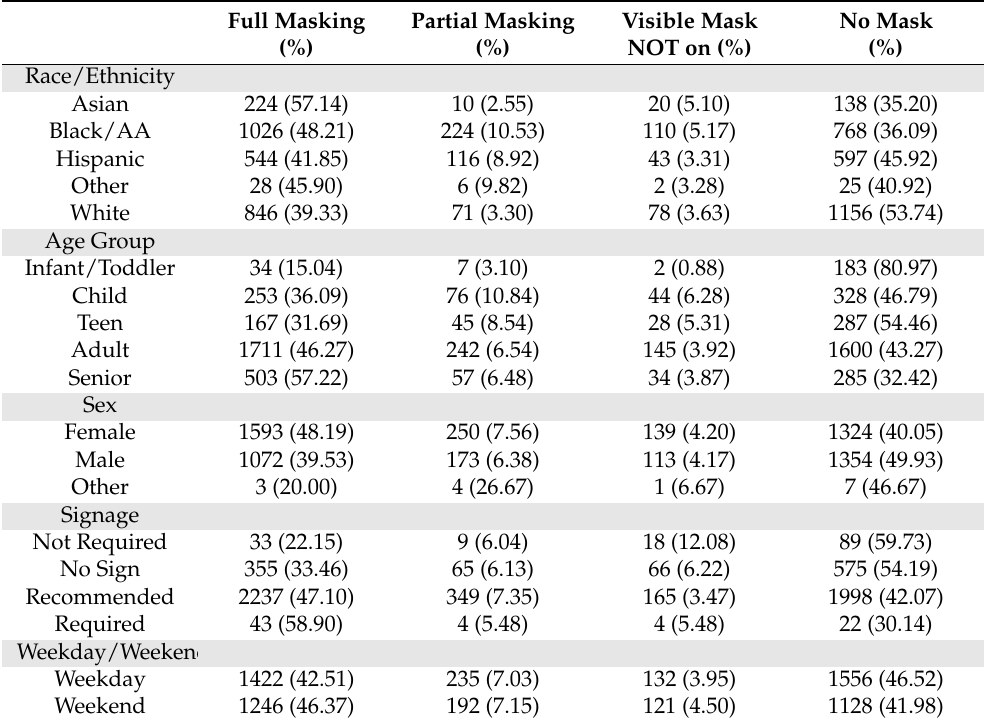
Table 1. Overall masking behavior by